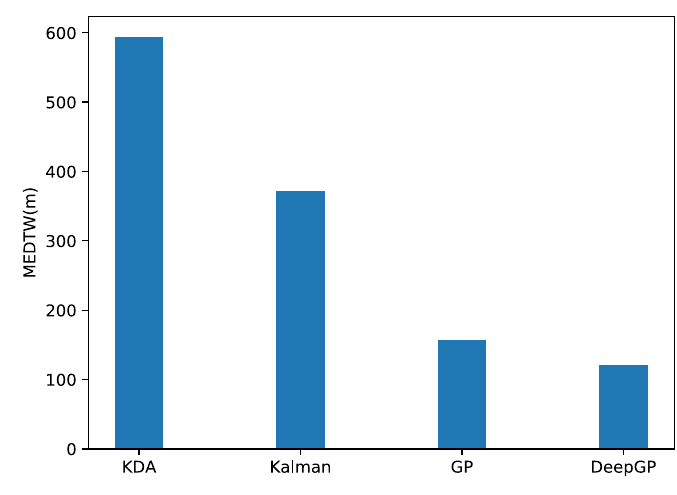
Figure 9. Experimental results for flight turn.